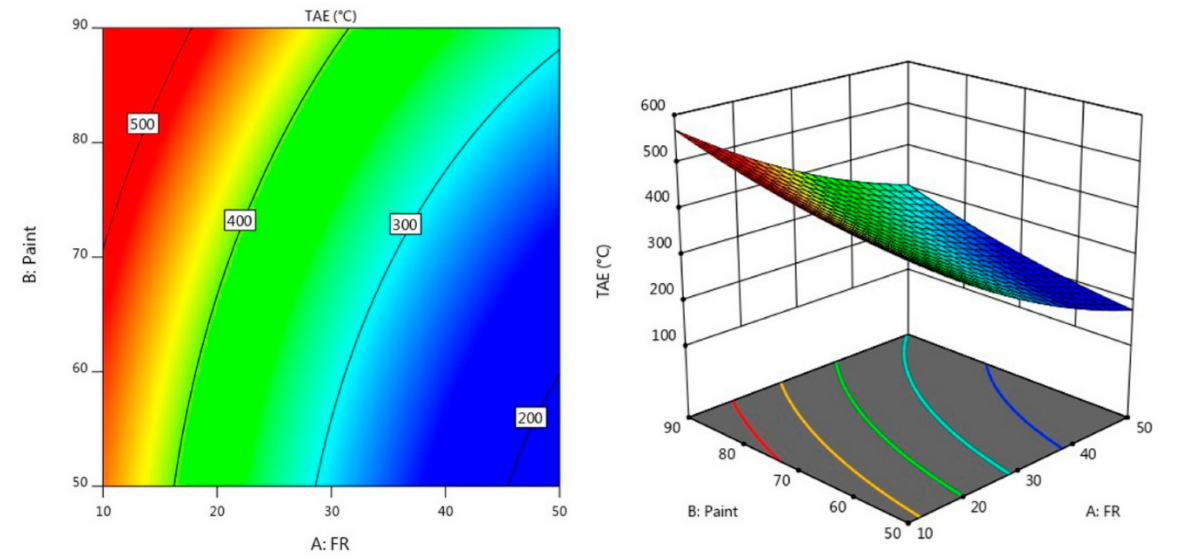
Figure 4. Contour plot for the effect of FR and paint on TAE in the fire resistance